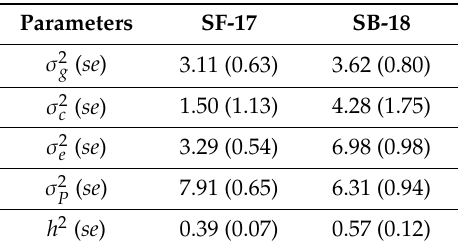
Table 1. Variance components and heritability estimates for cardiomyopathy syndrome (CMS) resistance in the two Atlantic salmon populations investigated in this study, StofnFiskur year-class 2017 (SF-17) and SalmoBreed year-class 2018 (SB-18).